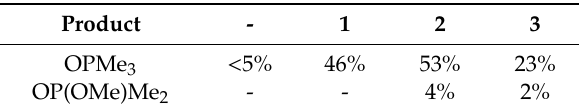
Table 3. Yield after 24 h in the aerobic oxidation of PMe 3